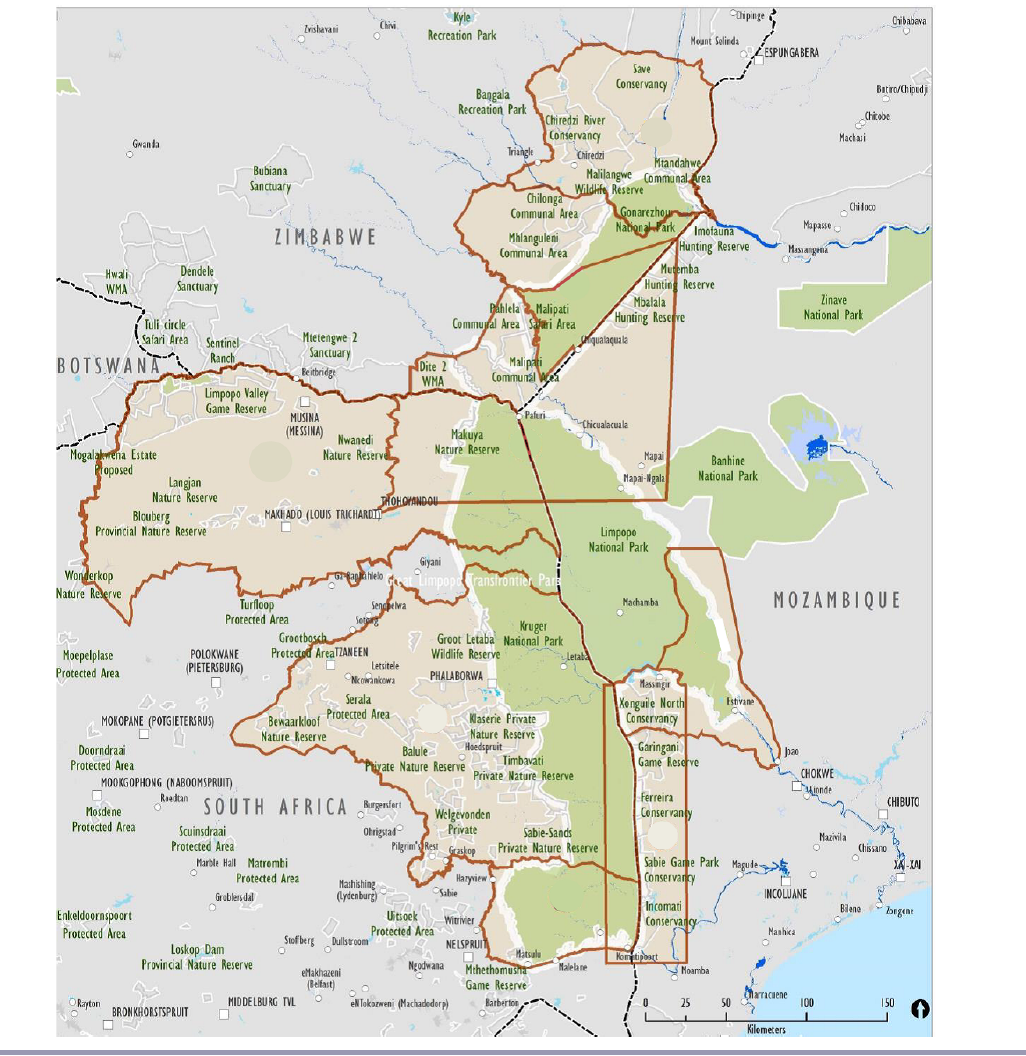
Fig. 2 . Map of the Great Limpopo Transfrontier Conservation Area. National parks are shown in dark green and neighboring communities situated in the region are shown in light